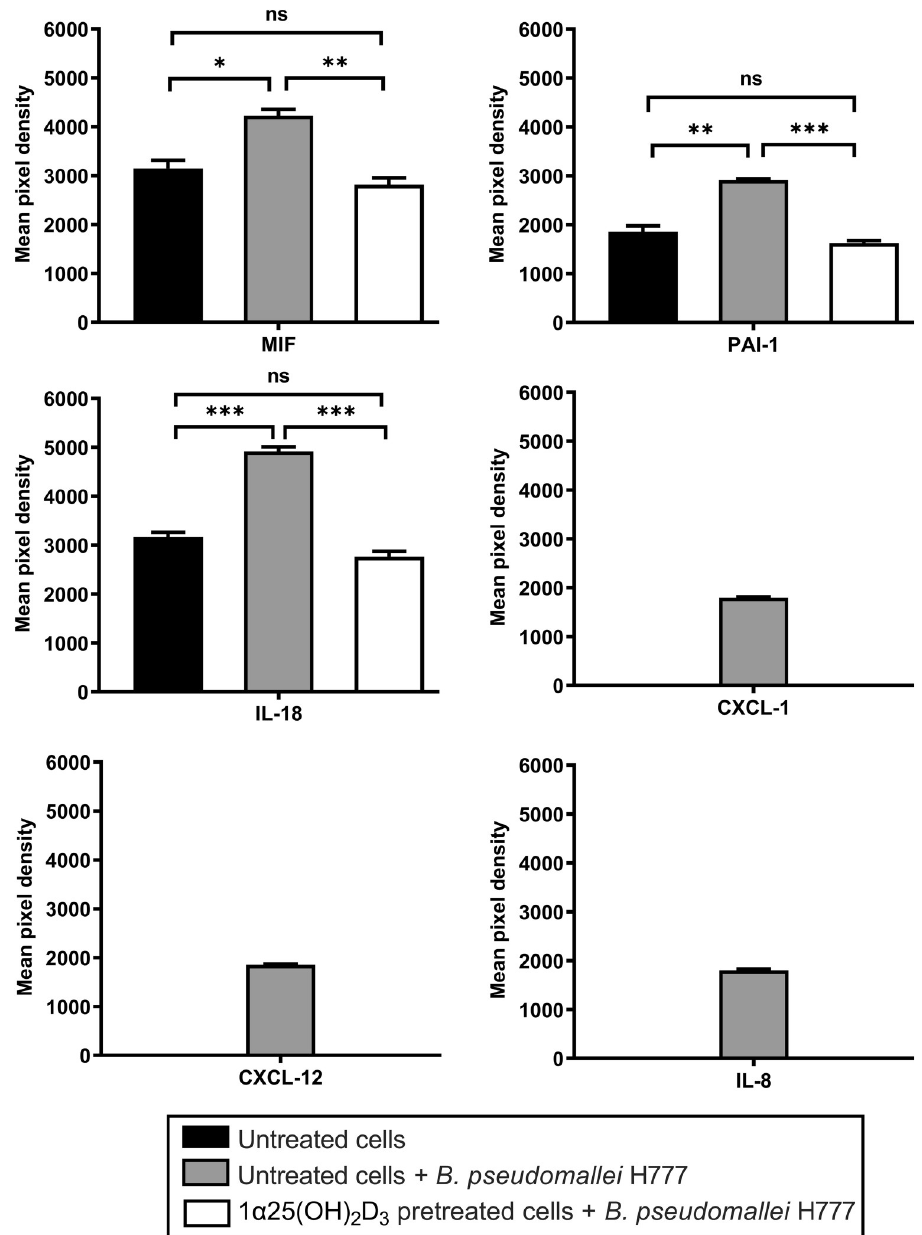
Fig 7. Cytokine expression during B . pseudomallei infection. Cytokine expression levels in all tested conditions were determined using cytokine antibody assays. The pixel density of each identified cytokine was calculated using ImageQuant TL Software. The results are shown as mean ± SD from two independent experiments carried out in duplicate. ns = not significant, � P < 0.05, �� P < 0.01 and ��� P < 0.001.